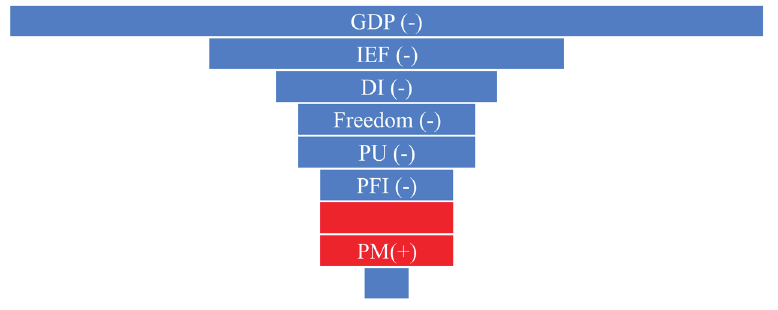
Fig. 3. Relative impact of covariates on outcome GII with treatment